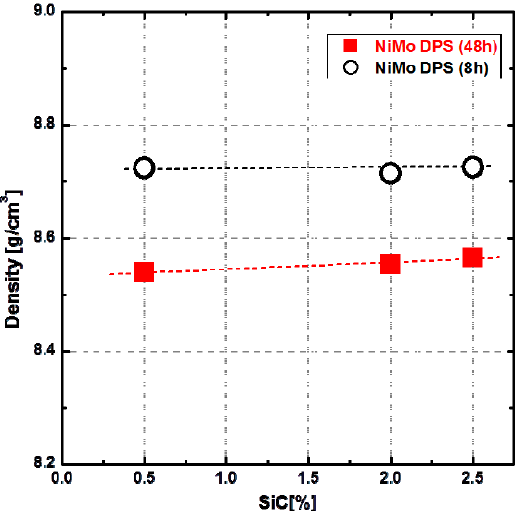
Figure 3. Density of 48-h-milled and 8-h-milled NiMo-SiC DPS alloys with an increasing amount of SiC in the initial powder mixture.